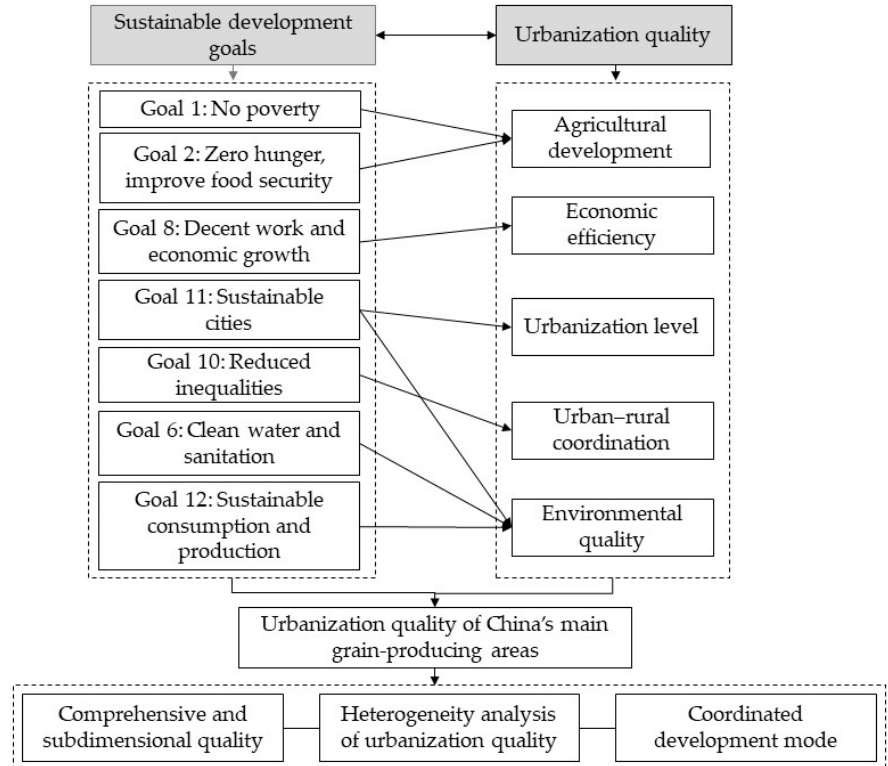
Figure 1. Analysis framework of the study.